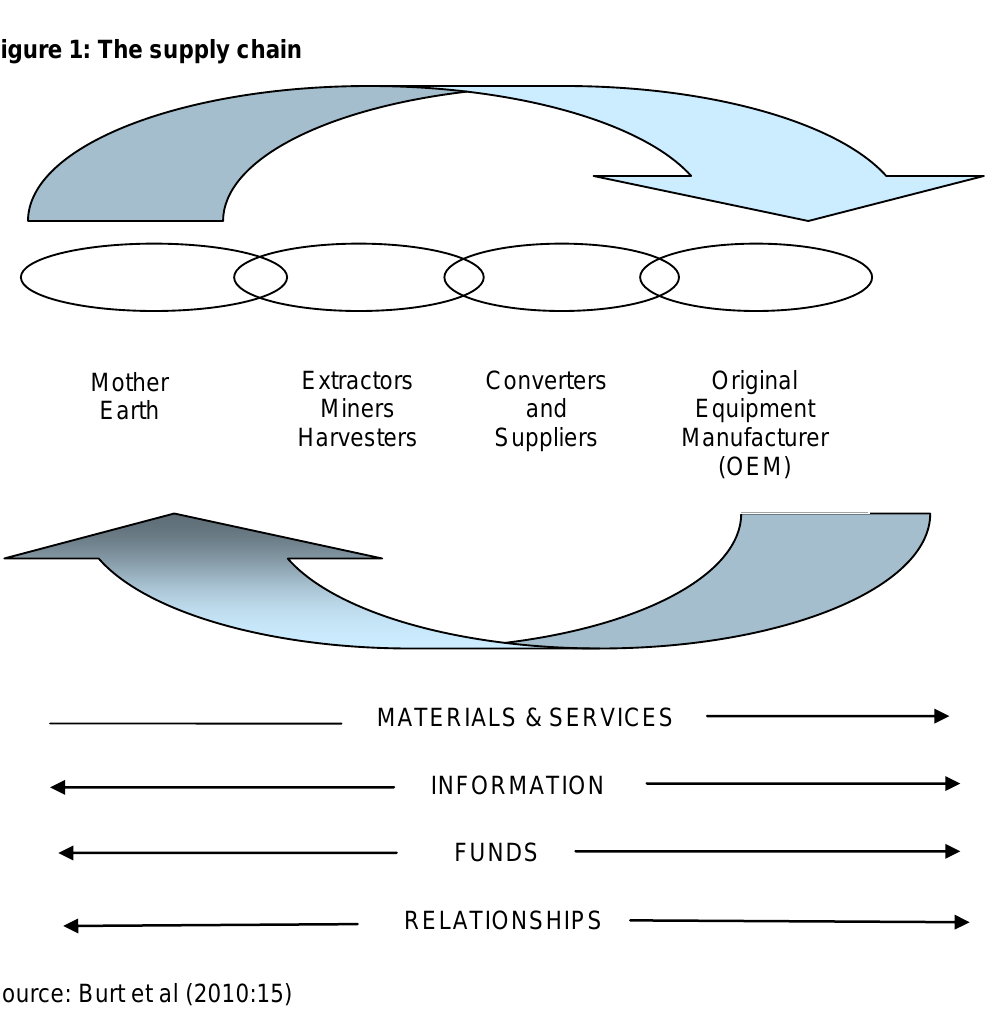
Figure 1: The supply